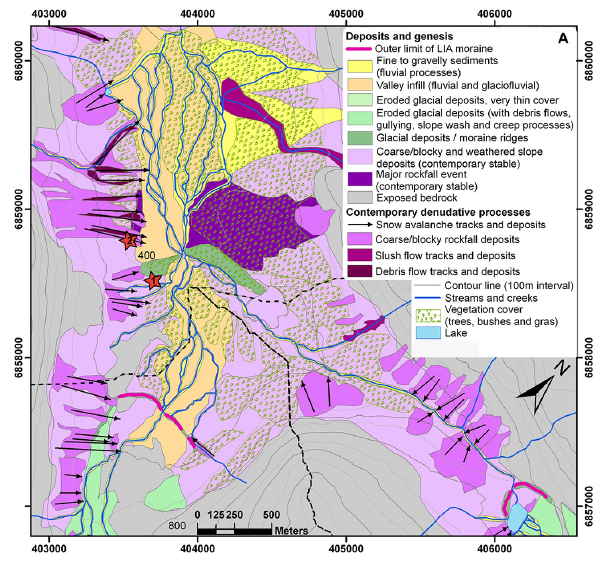
Figure 2. Geomorphological map of the Erdalen drainage basin (modified after Laute and Beylich, 2012) and location of the study profiles 1) PE1 and 2)